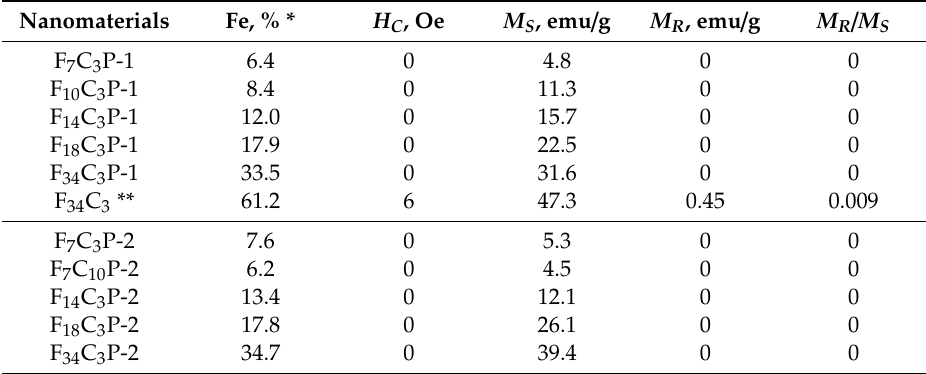
Table 5. Magnetic properties of